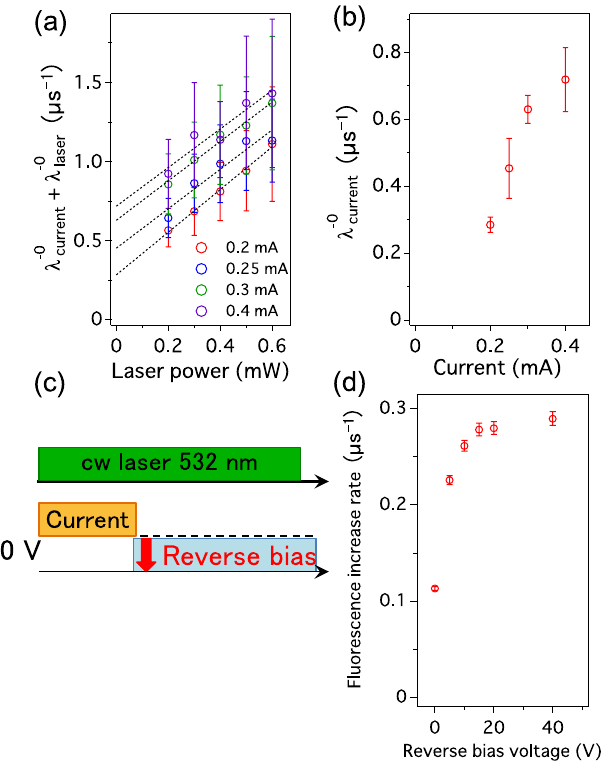
þ λ − 0 FIG. 3. (a) Dependence of the rate λ − 0 on the laser current laser power estimated from the experiment in Fig. 2(c). The dotted lines are the linear fitted lines for each injected current value. (b) Dependence of λ − 0 on the injected current. The values of current λ − 0 were derived from those when the laser power is zero in the current fitting of Fig. 3(a). (c) A pulse sequence to apply reverse bias voltage after forward bias. (d) Dependence of the fluorescence increase rate on the reverse bias voltage. A laser power was fixed to 0.4 mW during forward and reverse current injection. A forward bias current was fixed to 0.5